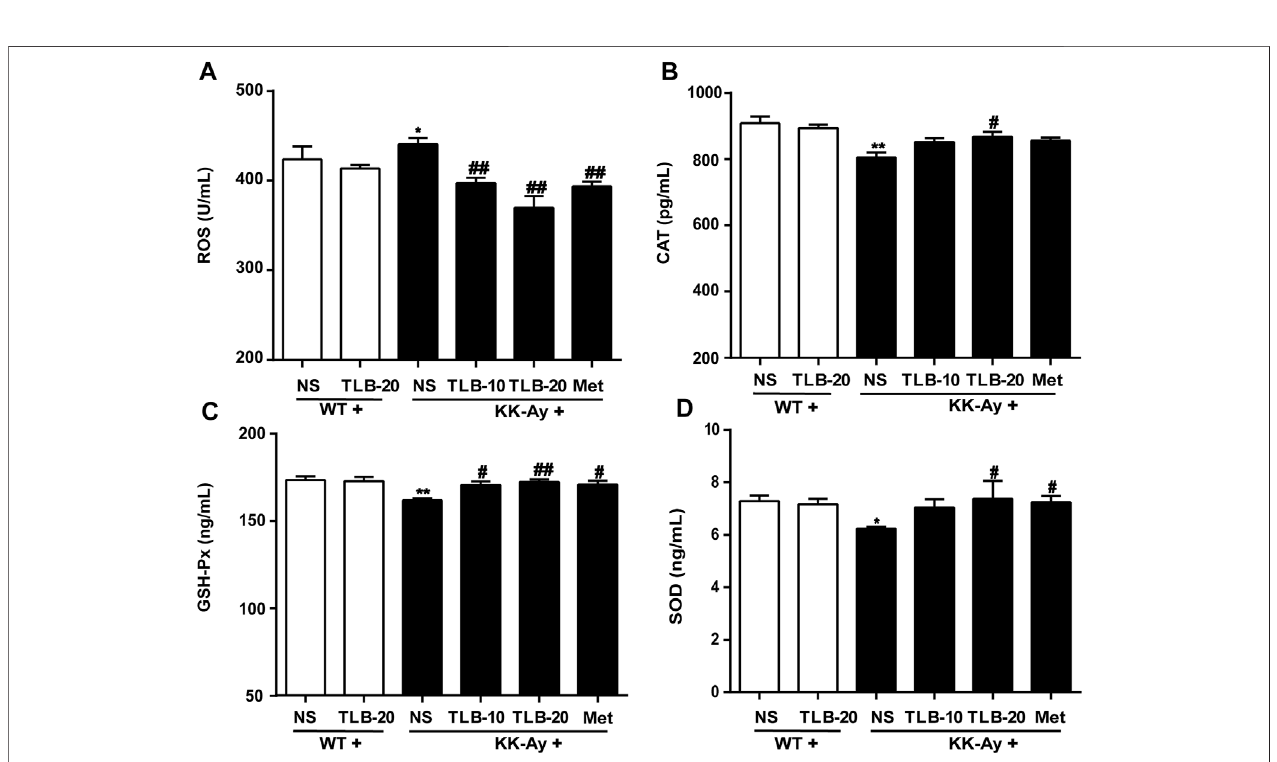
FIGURE6| TLBmitigatedoxidativestressinKK-Aymice. (A) ROScontent. (B) CATactivity. (C) GSH-Pxactivity. (D) SODactivity.* p < .05; **p < .01 vs. WTgroup; # p < 0.05, ## p < .01 vs. KK-Ay group; n = 6 – 9 per group, mean ± SEM.